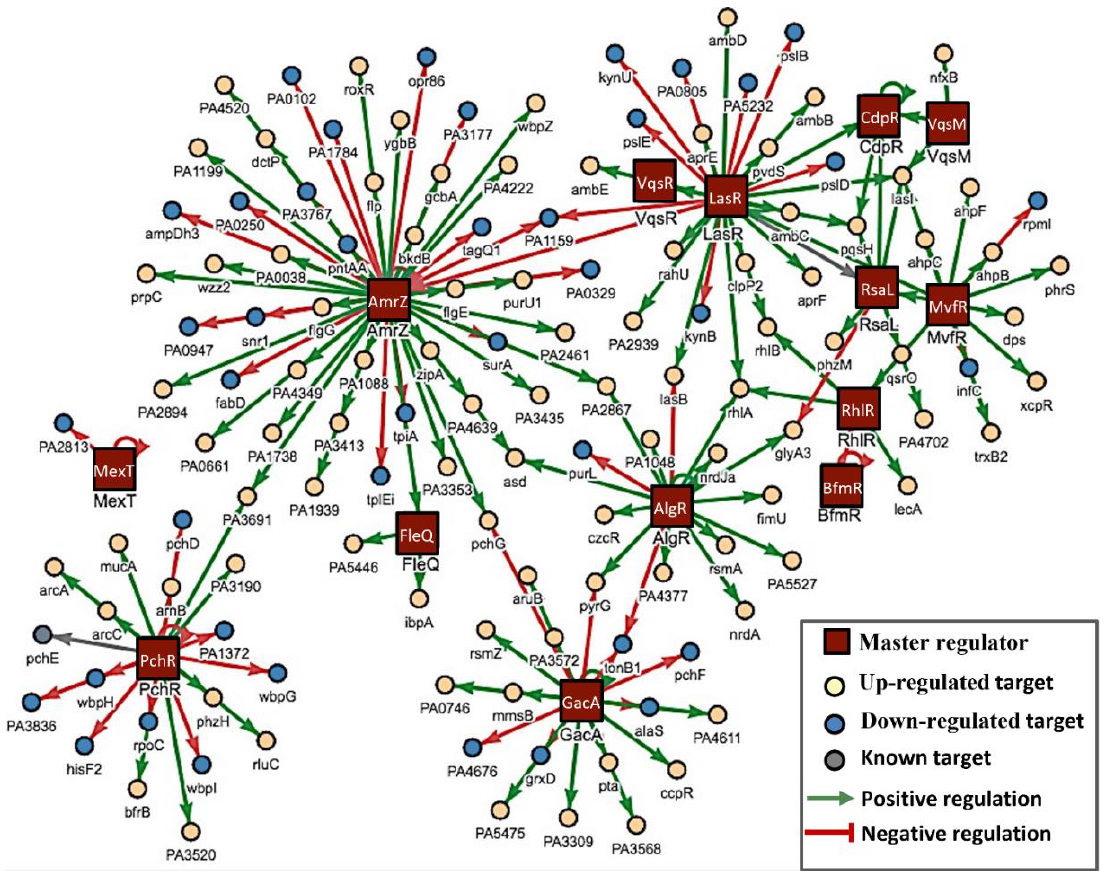
Figure 4. PAGnet master regulators network. The regulons shown as red squares represent 14 downregulated master regulators of P. aeruginosa . The red solid line is the negative regulation, and the green solid line is the positive regulation. The individual circle presents the functional targets of each regulon. Positively regulated targets (yellow), negatively regulated targets